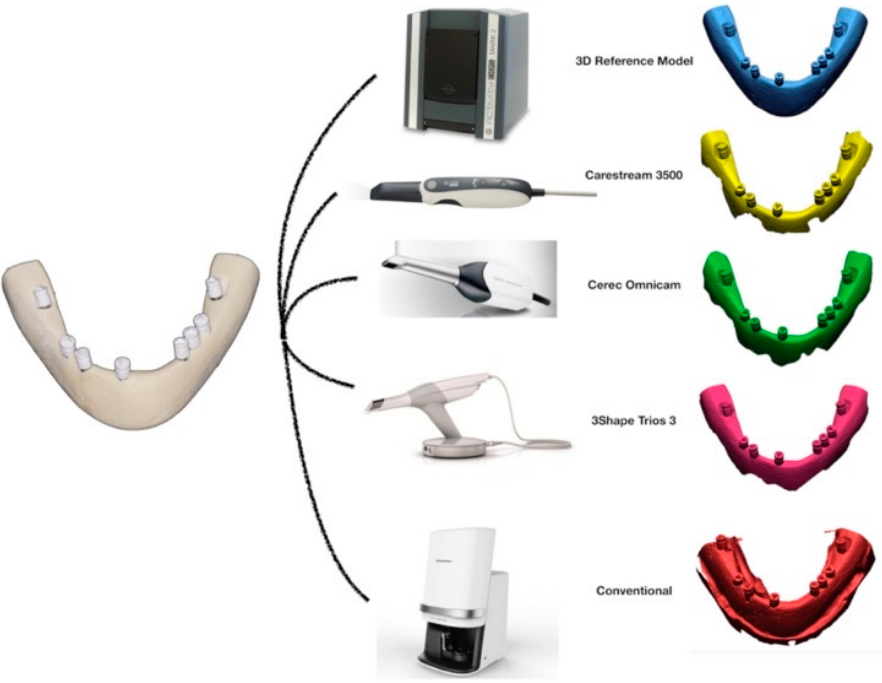
Figure 3. Entire impression groups.